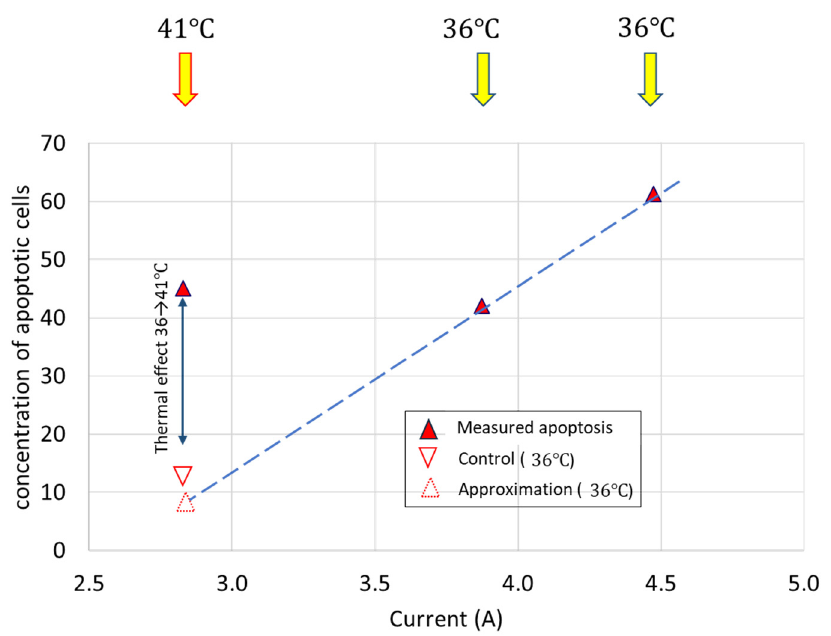
Figure 11. The apoptosis linearly increases by the increase of current density. The higher current density was reached by intensive cooling of the sample, keeping the medium at 36 °C, while the standard treatment was at 41 °C. The difference in the approximated apoptosis at low current at 36 and at 41 °C is produced by the thermal effect.